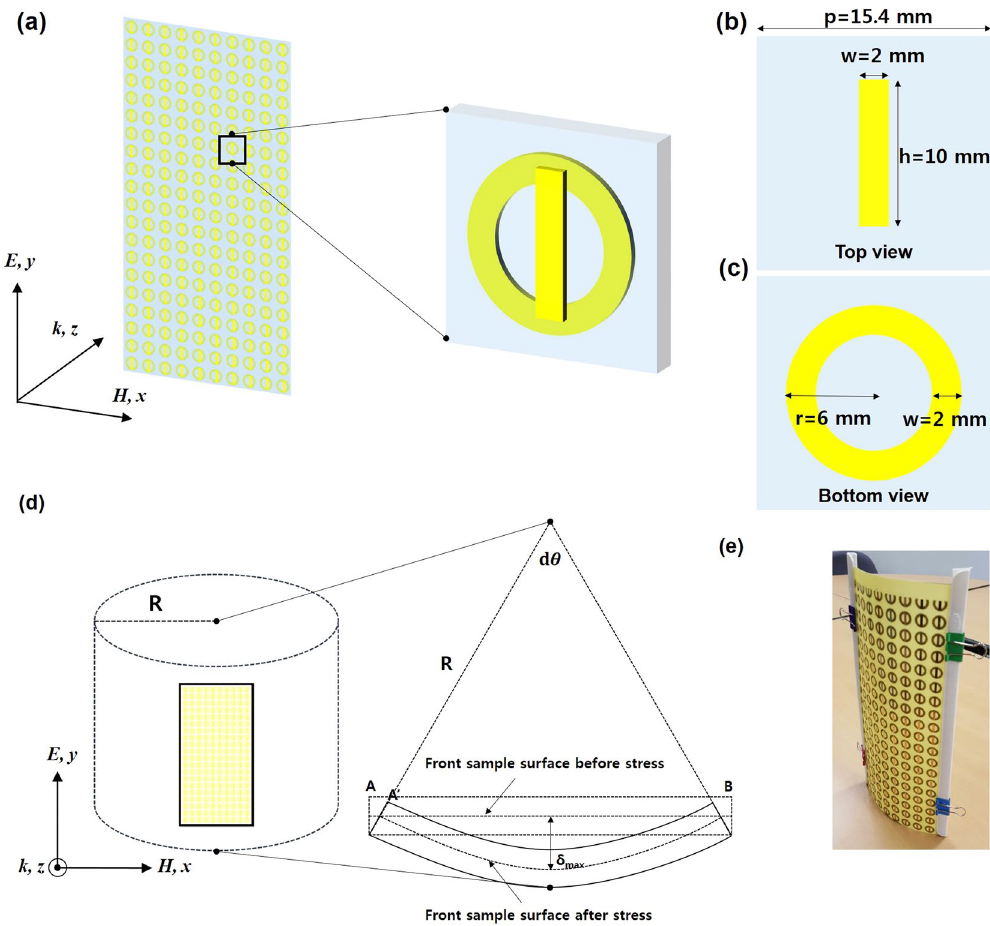
Figure 1. ( a ) Schematic view of the unit cell of proposed design. ( b ) Two-dimensional top view of a copper- based CWR and ( c ) bottom view of an RR with the geometrical parameters. ( d ) Schematic of the bent structure based on hollow tube. Polarization of incident wave is also shown. ( e ) Fabricated MM sample under